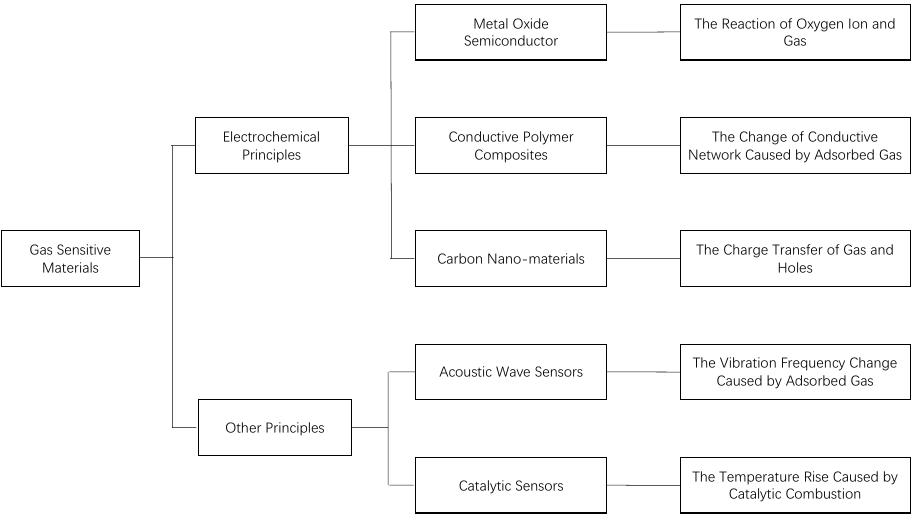
Figure 3. Classification of Gas Sensitive Materials